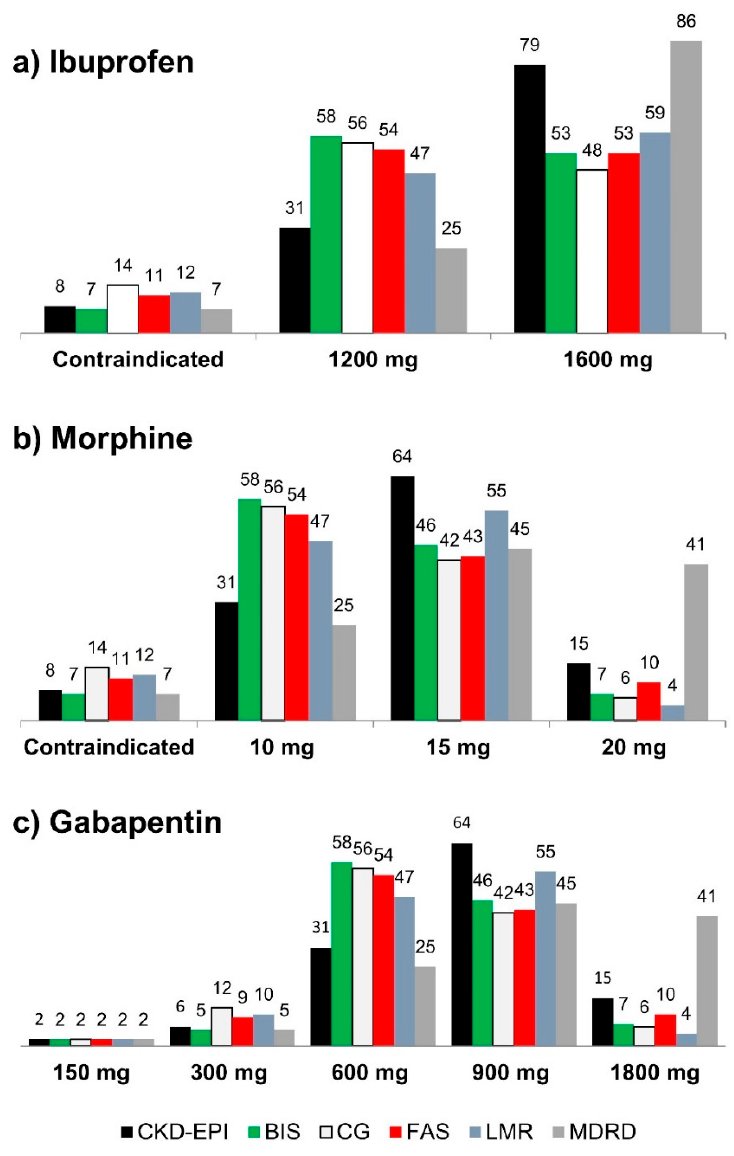
Figure 1. ( a – c ) Simulated recommended doses of ibuprofen ( a ), morphine ( b ), and gabapentin ( c ) according to the six different creatinine-based eGFR equations (n = 118). CKD-EPI Chronic Kidney Disease Epidemiology Collaboration, BIS Berlin Initiative Study, CG Cockcroft-Gault, FAS Full Age Spectrum, LMR Lund-Malmö revised, MDRD Modification of Diet in Renal Disease